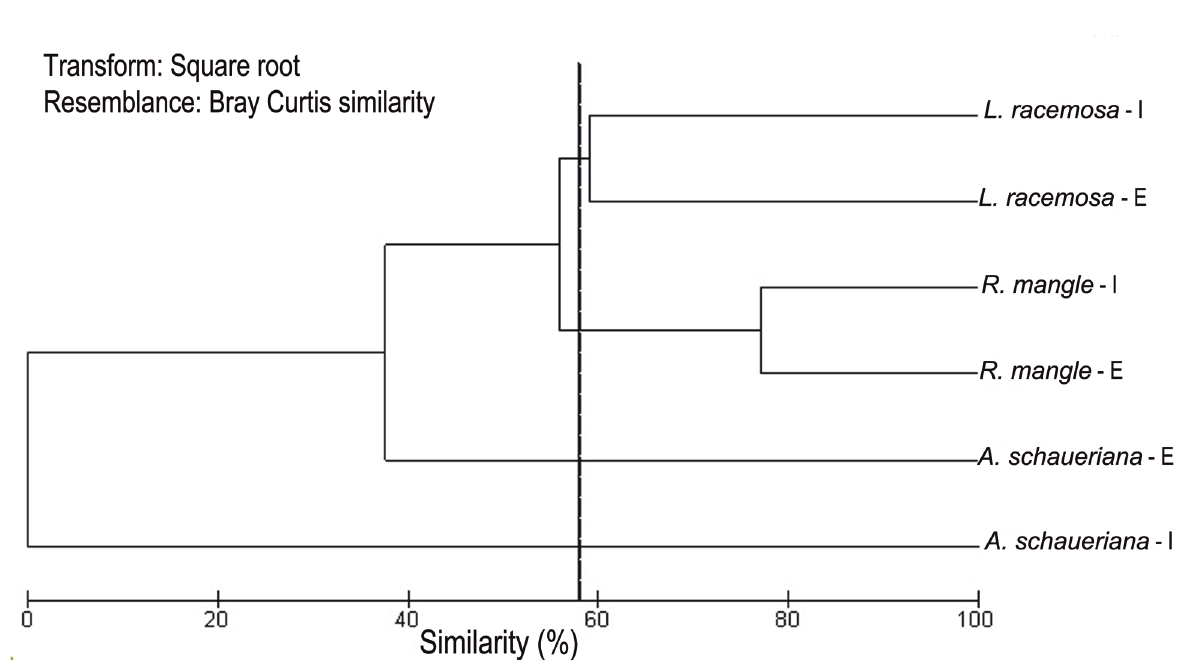
Figure 5 - Cluster analysis based on bromeliad abundances recorded in each host tree species and in each transect (E = edge, I - interior). The Bray Curtis coefficient grouped the host species ( L. racemosa and R. mangle ) at 58% of similarity, independently of the transect.